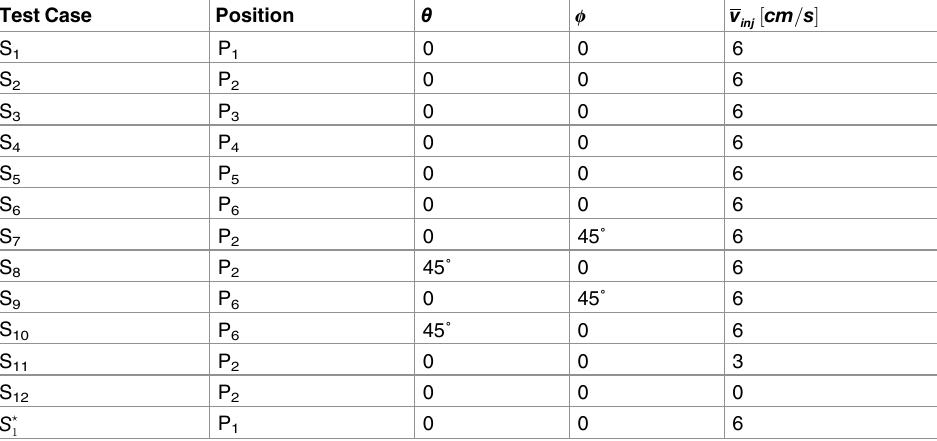
Table 1. Summary of injection simulations and parameters